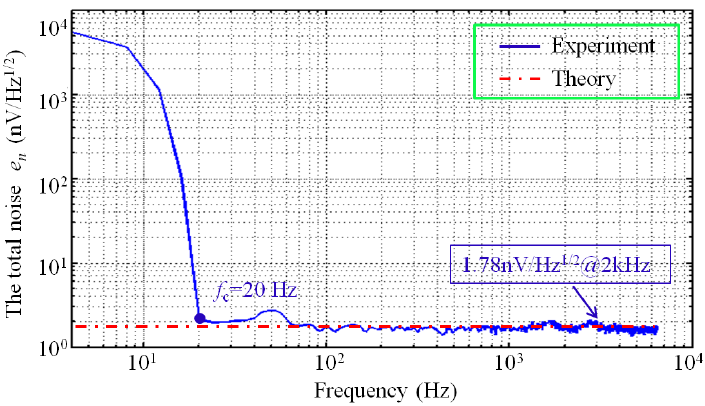
Figure 12. The total noise e n of the proposed CSMN.